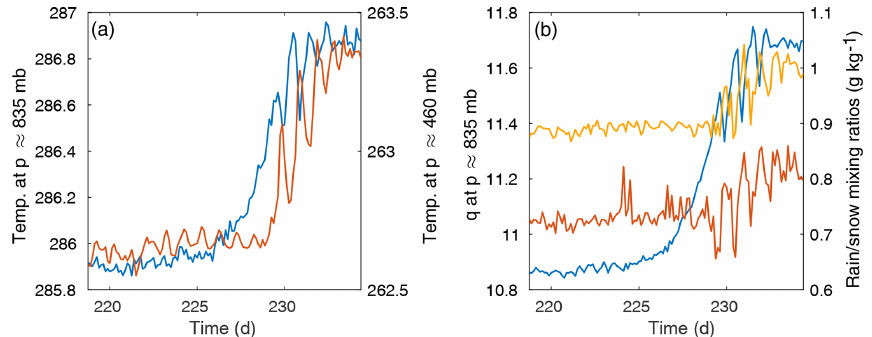
Figure 7. (a) Left axis (blue): temperature ( T ) evolution at a randomly selected level from the lower part of the column ( p ≈ 835mb). Right axis (red): temperature evolution at a randomly selected level from the upper part of the column ( p ≈ 460mb). (b) Left axis: water vapor mixing ratio ( q ) evolution at p ≈ 835mb (blue). Right axis: the rain (red) and snow (yellow) mixing ratios’ evolution at p ≈ 835 and p ≈ 460mb, respectively. The evolution of the latter (microphysics) variables is largely determined by the upper